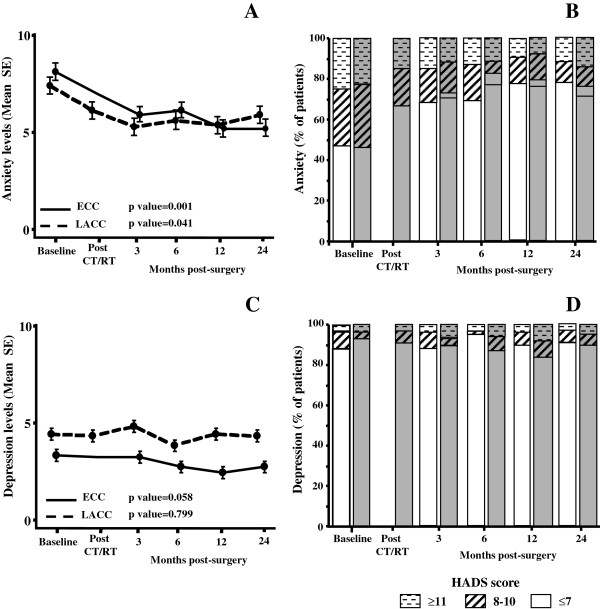
Plots of HADS-anxiety (A) and depression (C) mean scores at each assessment (Error bars indicate standard deviations). Longitudinal changes over time in the distribution of patients with normal (HADS scores≤7), borderline (HADS scores 8–10), and severe (HADS scores ≥11) levels of anxiety (B) and depression (D) according to the extent of disease; ECC patients: white column, LACC patients: gray columns.